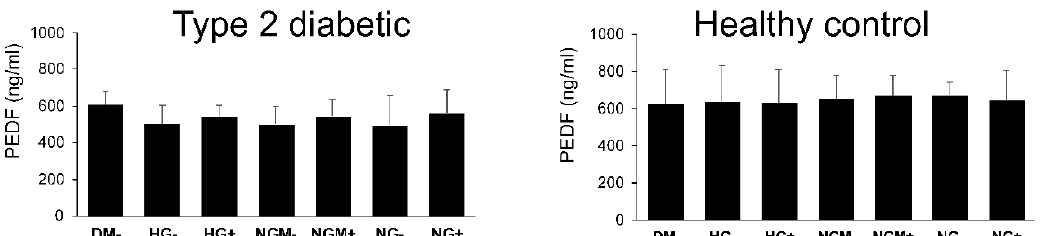
Figure 6. The effects of glucose and insulin concentration and extracellular stress on pigment epithelial growth factor (PEDF) secretion. The amount of PEDF was assessed using enzyme-linked immunosorbent assay (ELISA) from medium samples after a 24 h collection of apical and basal side (1 + 1). Medium was from hiPSC-RPEs derived from type 2 diabetic (UTA.08002.DMs, UTA.08203.DMs, and UTA.10802.EURCCs) and healthy control (UTA.10902.EURCCs) patients (1–3 biological replicates, 1 technical replicate).